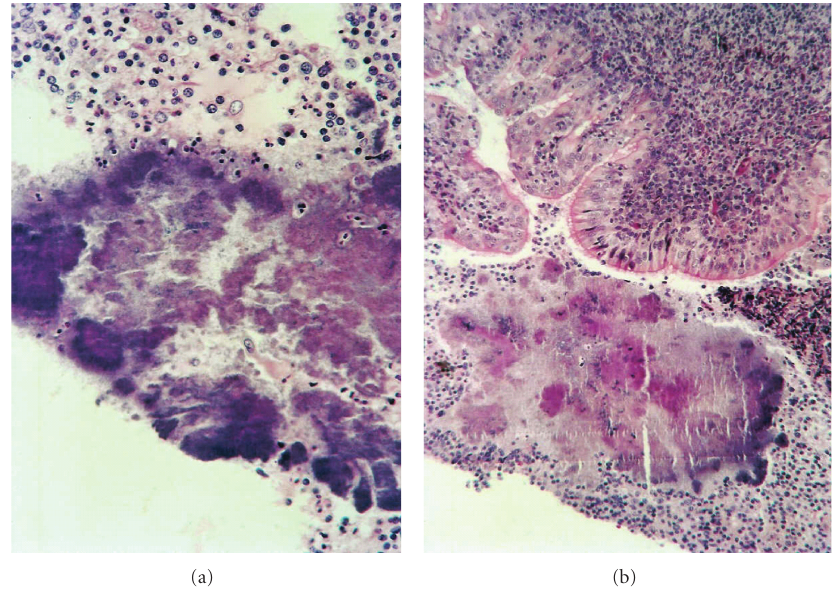
Figure 2: Chronic inflammation and presence of